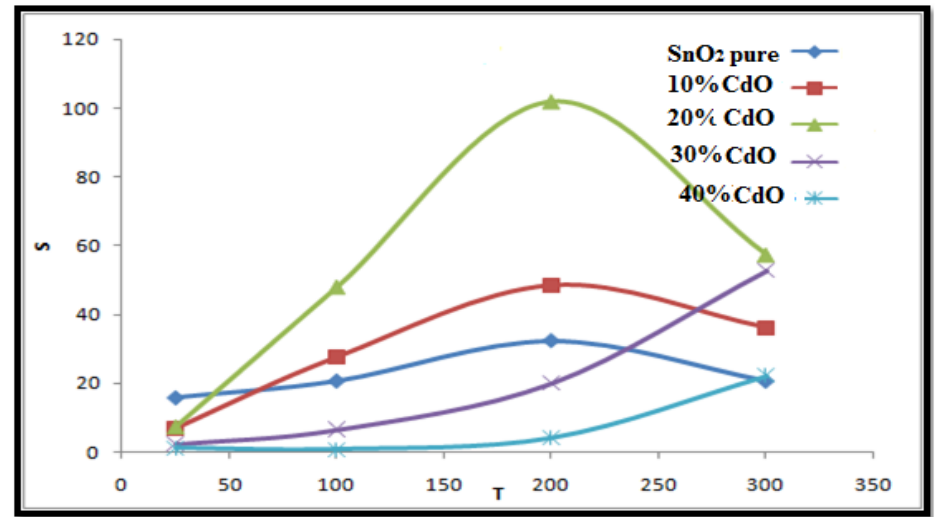
Fig. 5: Sensing characteristics of SnO